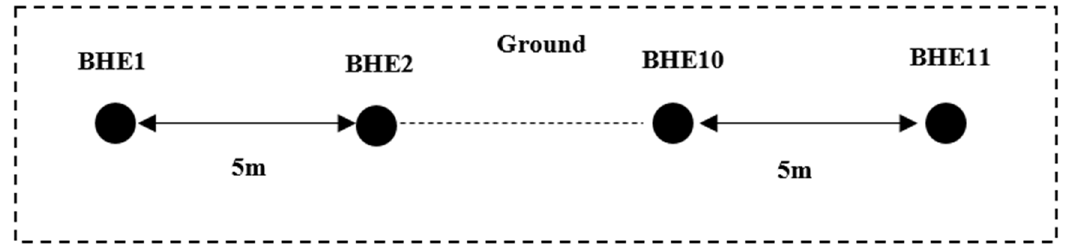
Figure 8. Top view of eleven boreholes.